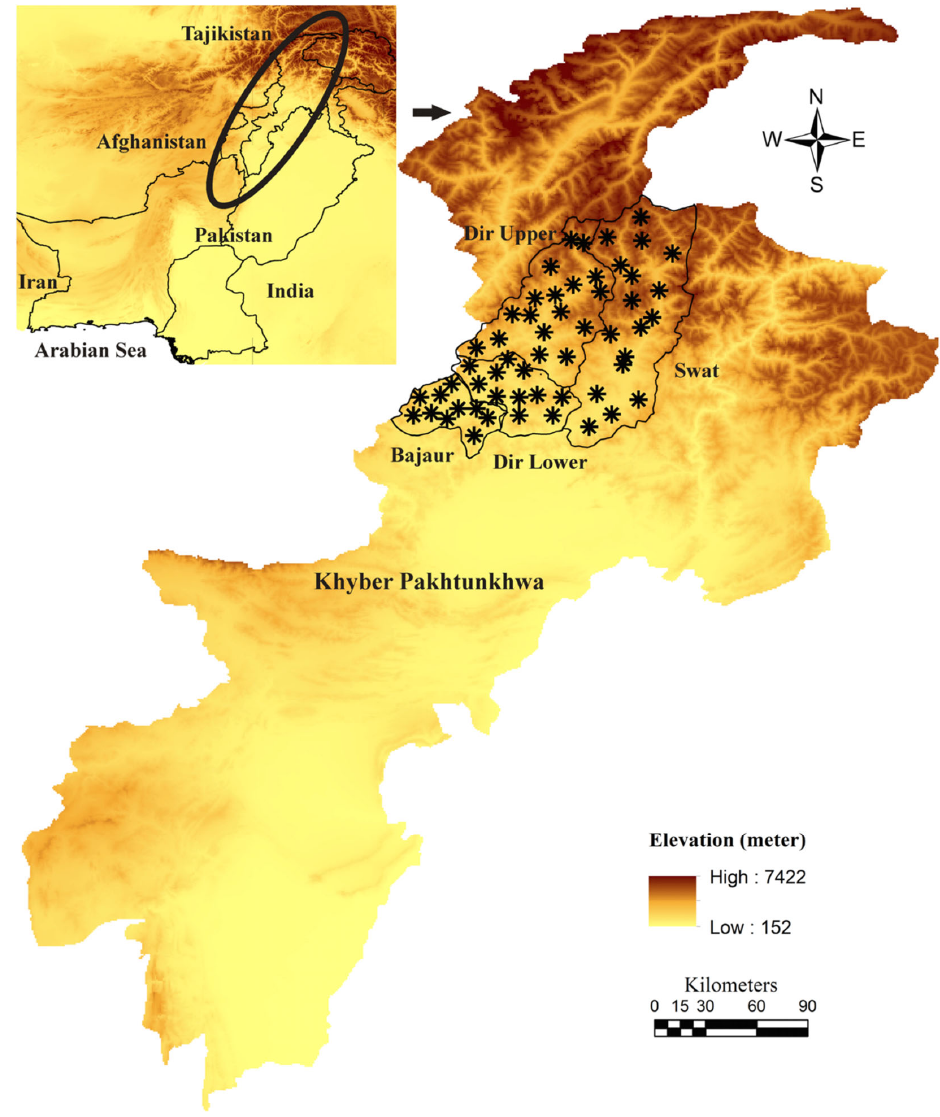
Figure 1. Elevation ‐ based map showing tick collection sites (black